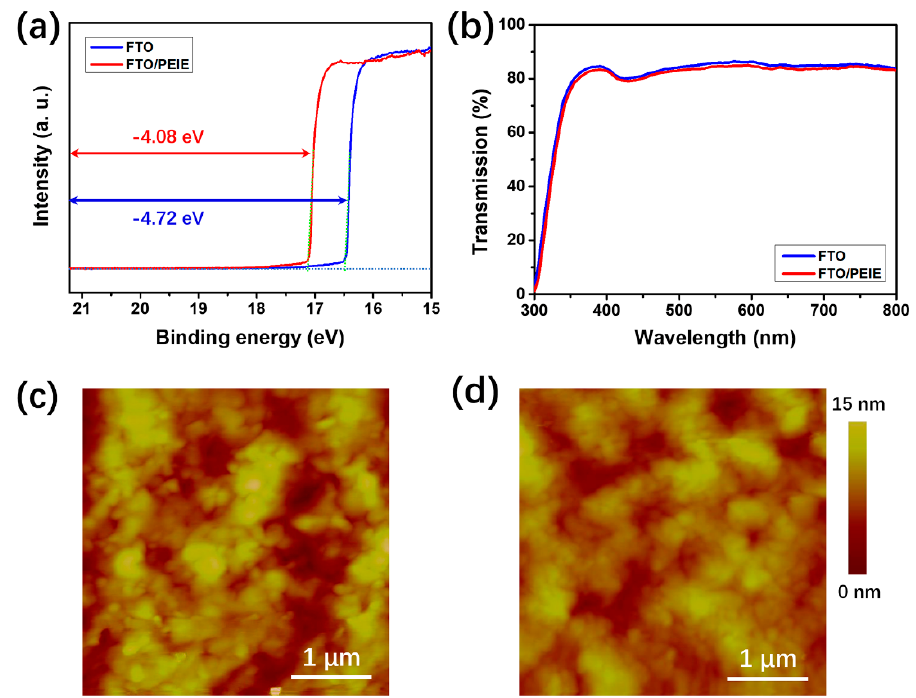
Figure 2. UPS ( a ) and transmission ( b ) spectra of bare FTO and FTO/PEIE electrodes; AFM height images of bare FTO ( c ) and FTO/PEIE ( d ) electrodes.